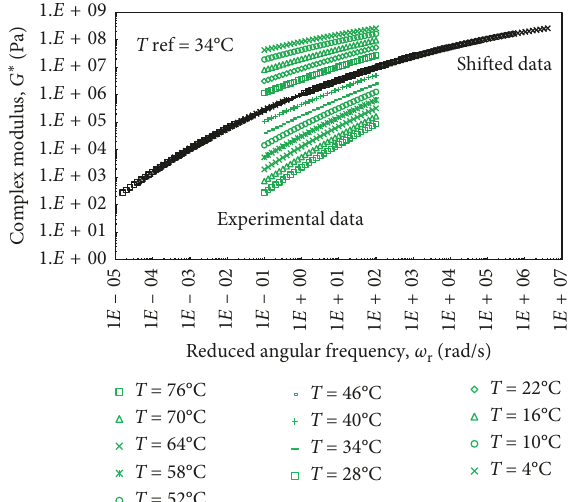
Figure 13: Complex modulus master curve ( G